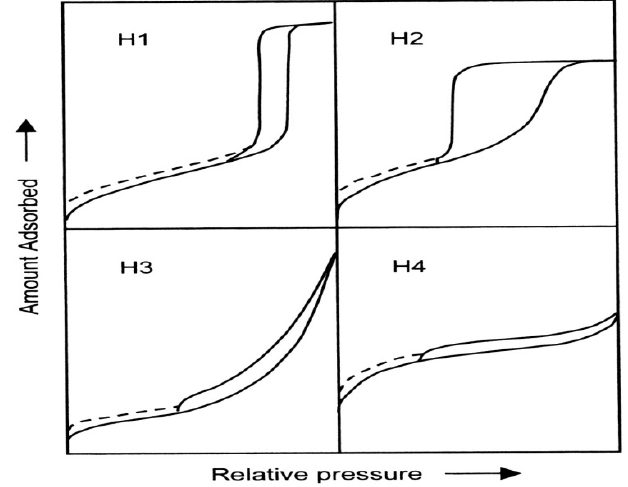
Figure 4. The relationship between the pore shape and the adsorption-desorption isotherm.